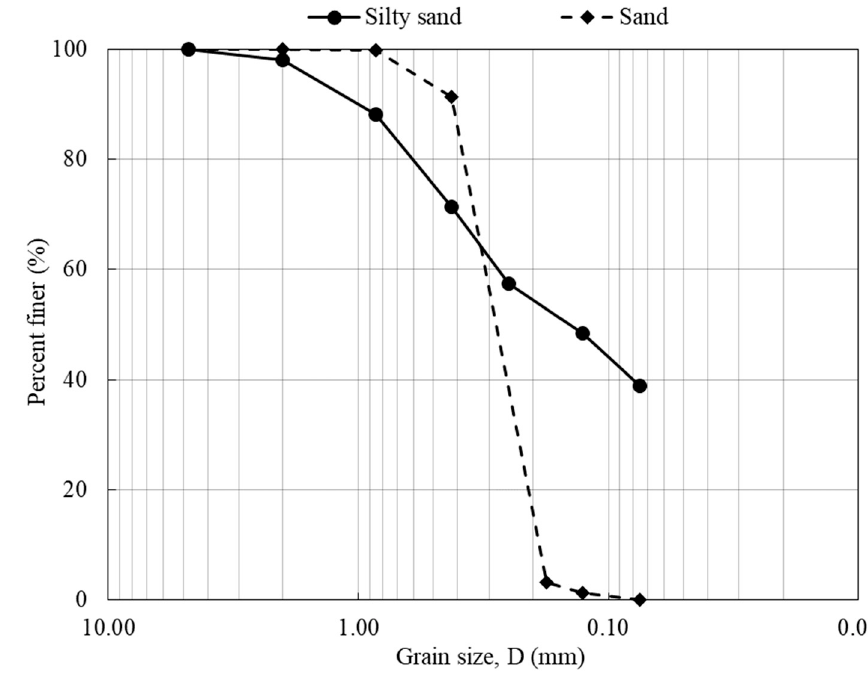
Figure 1. Grain size distribution of the soils used in this study.